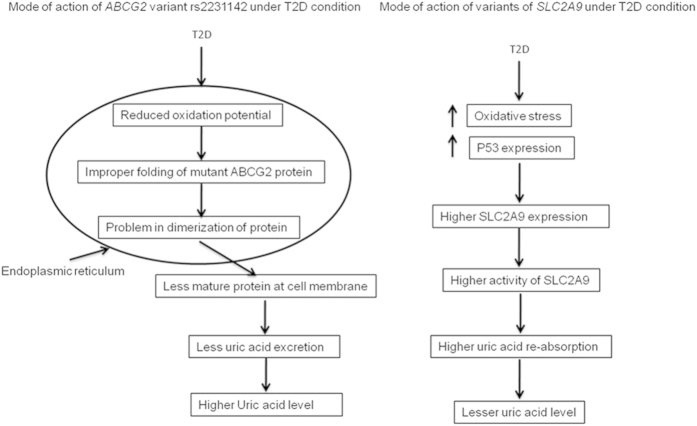
Mode of action of variants in ABCG2 and SLC2A9 genes under T2DM condition.